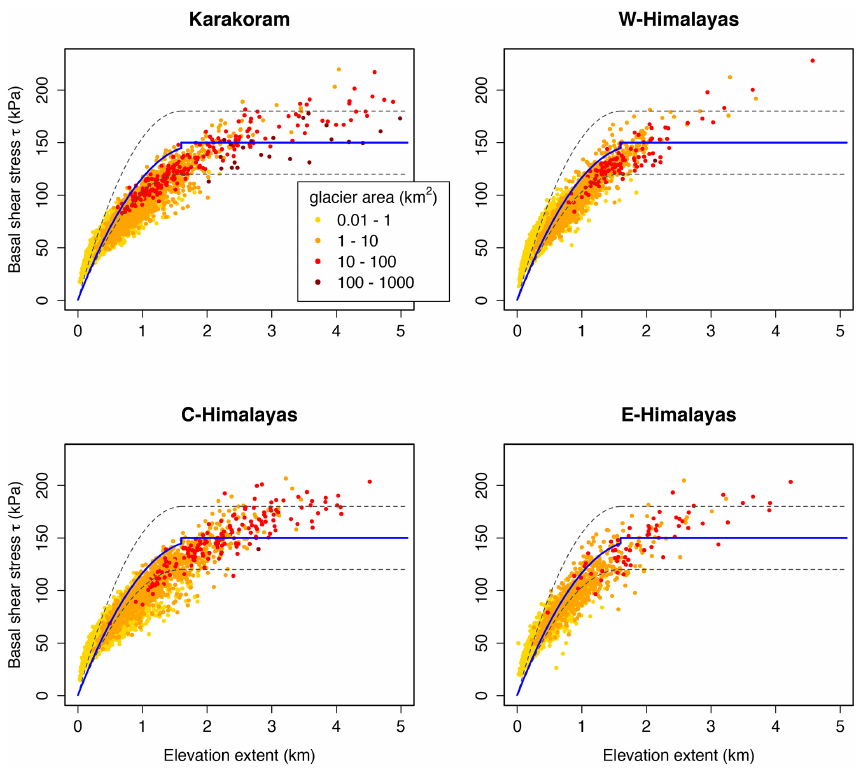
Figure 9. Basal shear stresses calculated by the HF-model (colored dots) compared to the applied parameterizations for GlabTop2 and the slope-dependent thickness estimations (blue line; dashed lines represent parameterizations used for sensitivity